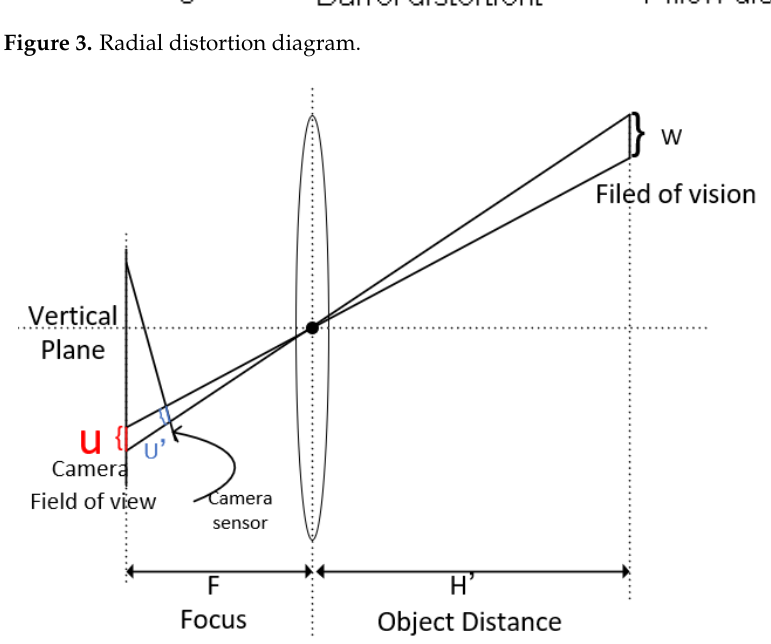
Figure 4. Tangential distortion diagram.